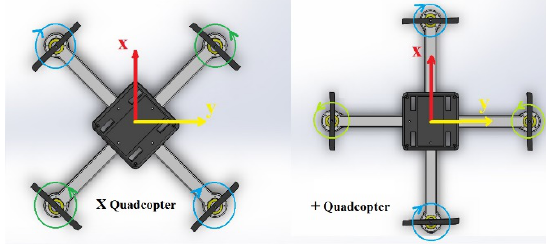
Figure 1. Quadrotor flight